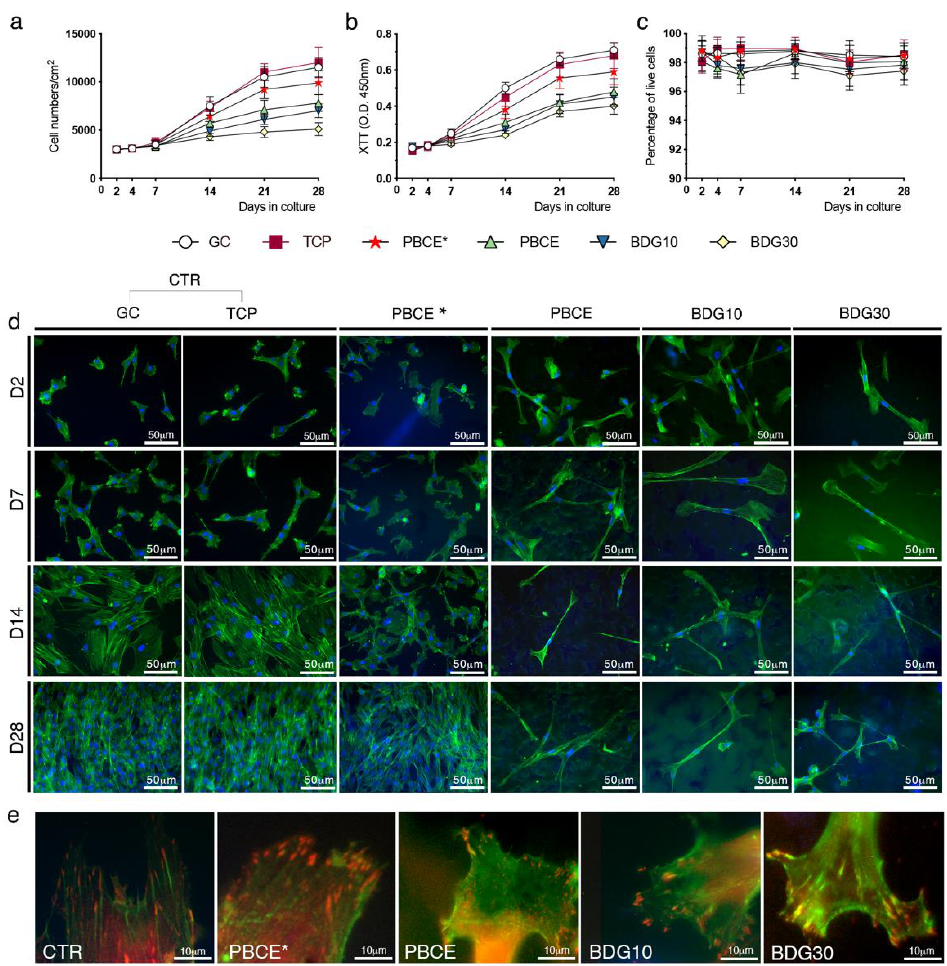
Figure 2. PBCE, BDG10 and BDG30 polymer films, but not PBCE*, change the hBM-MSC shape. ( a ) Growth curves of cell proliferation on polymer films, TCP and GC. ( b ) XTT viability assay showed the absence of cytotoxicity in cells on polymer films, TCP and GC. ( c ) Percentage of live cells on polymer films, TCP and GC at each time point of culture. The results in a,b,c, are expressed as mean ± SD of three independent experiments, p < 0.05. ( d ) Representative fluorescence images of hBM-MSC nuclei (DAPI, blue) and F-actin (FITC-phalloidin, green) revealed the stem cell canonical fibroblast-like morphology on TCP and GC and the change of the cell shape only on PBCE-films. Scale bar 50 µ m. ( e ) Representative fluorescence images of hBM-MSCs vinculin (red) and F-actin (FITC-phalloidin, green) showed the focal adhesion spots on CTR (TCP / GC) and polymer films. Scale bar 10 μm .